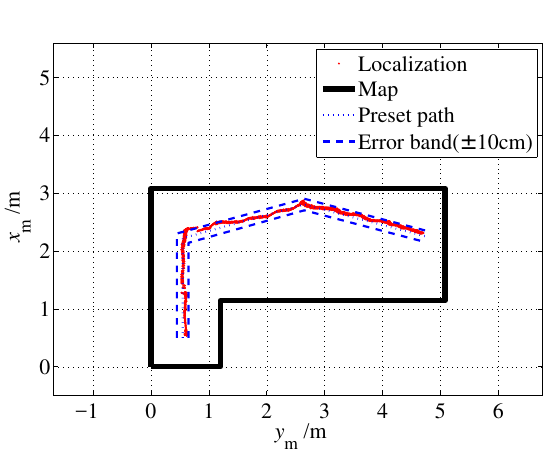
Figure 20. Localization result (without unmodeled